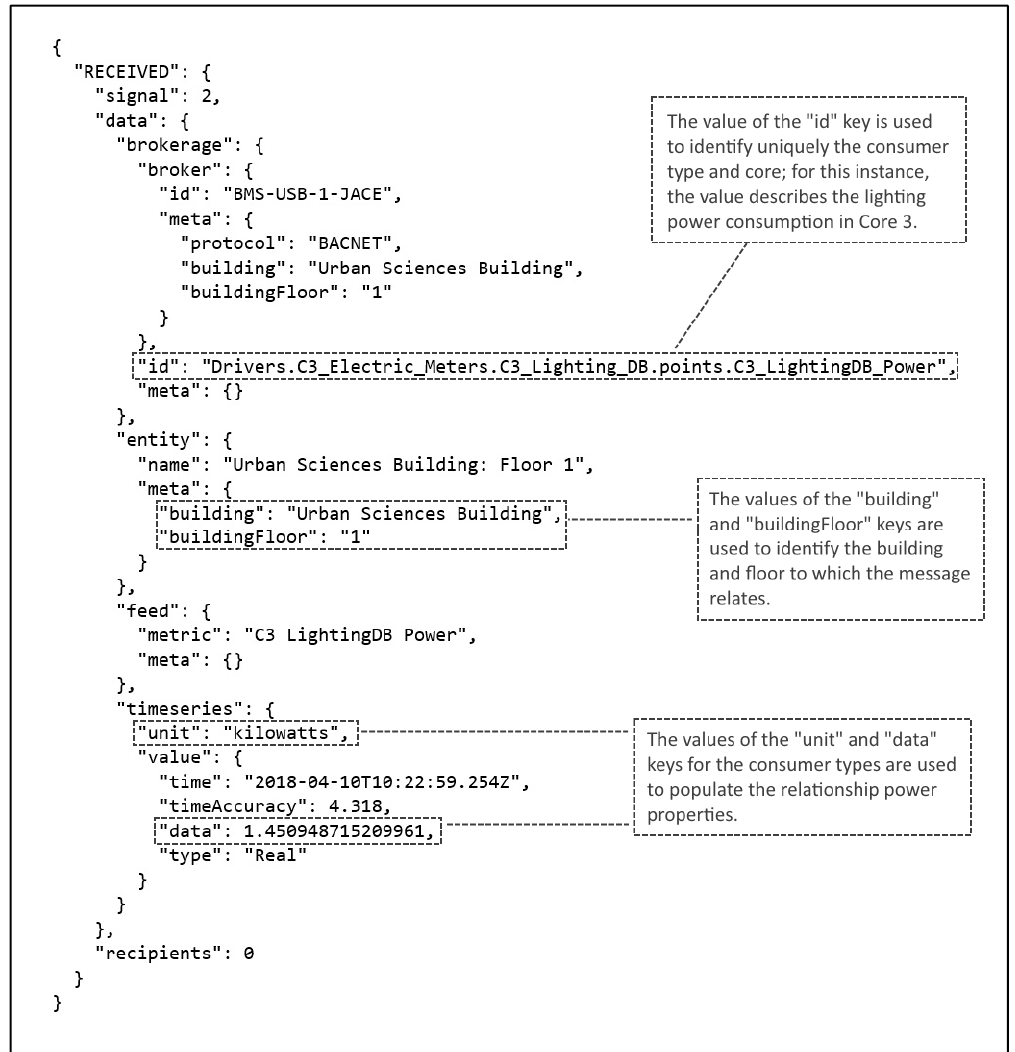
Figure 5. A single JSON message recording the lighting power consumption in core 3 of the first floor of the USB as 1.45 kilowatts.